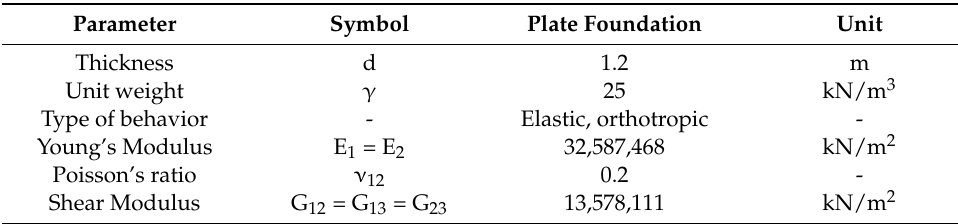
Table 6. Material properties of the